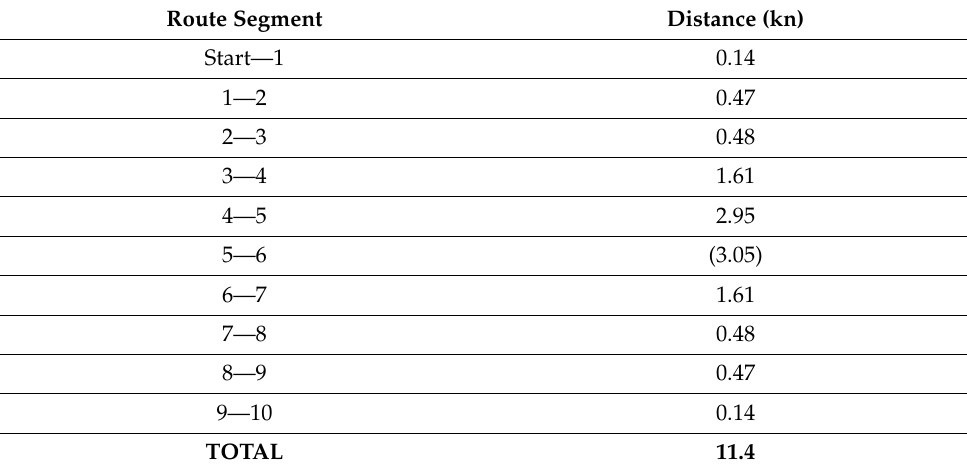
Figure 19. Route traveled by the simulated tugboat.